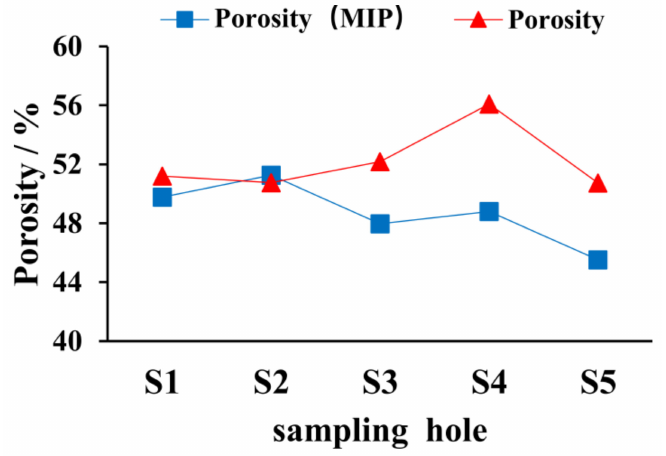
Figure 10. Comparison between porosity (MIP) and calculated